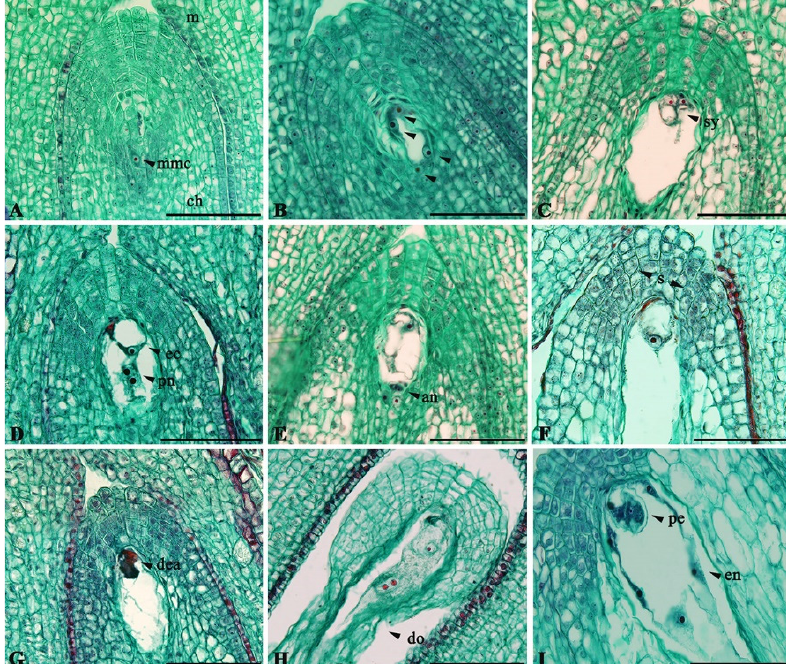
Figure 2. Embryo sac development in plum cultivars: ( A ) Megaspore mother cell—‘Edda’. ( B ) Four- nucleate state after second mitotic division—‘Mallard’. ( C ) Position of synergid cells—‘Jubileum’. ( D ) Normal position of the egg cell and polar nuclei—‘Jubileum’. ( E ) Antipodal cells—‘Reeves’. ( F ) Starch grains in nucellar cap tissue—‘Jubileum’. ( G ) Degeneration of elements in the embryo sac—‘Reeves’. ( H ) Degeneration of the ovule—‘Mallard’. ( I ) Early embryogenesis—‘Edda’. m: micropylar pole; ch: chalazal pole; mmc: megaspore mother cell; arrowheads: nuclei; s: synergid cells; ec: egg cell; pn: polar nuclei; an: antipodal cells; s: starch grains; dea: degenerated egg apparatus; do: degenerated ovule; pe: pro-embryo; en: endosperm nuclei. Scale bars = 200 µ